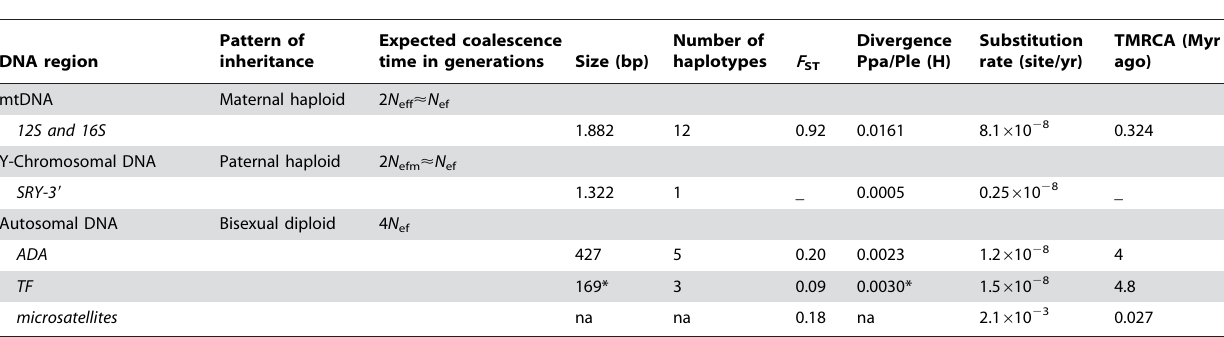
Table 1. Expected and observed coalescent times for the different markers studied in lions according to their pattern of